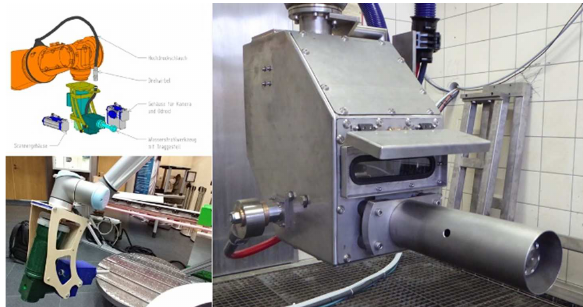
Fig. 5. CAD planning and development of final UHP waterjet nozzle with integrated and water protected laser scanner.